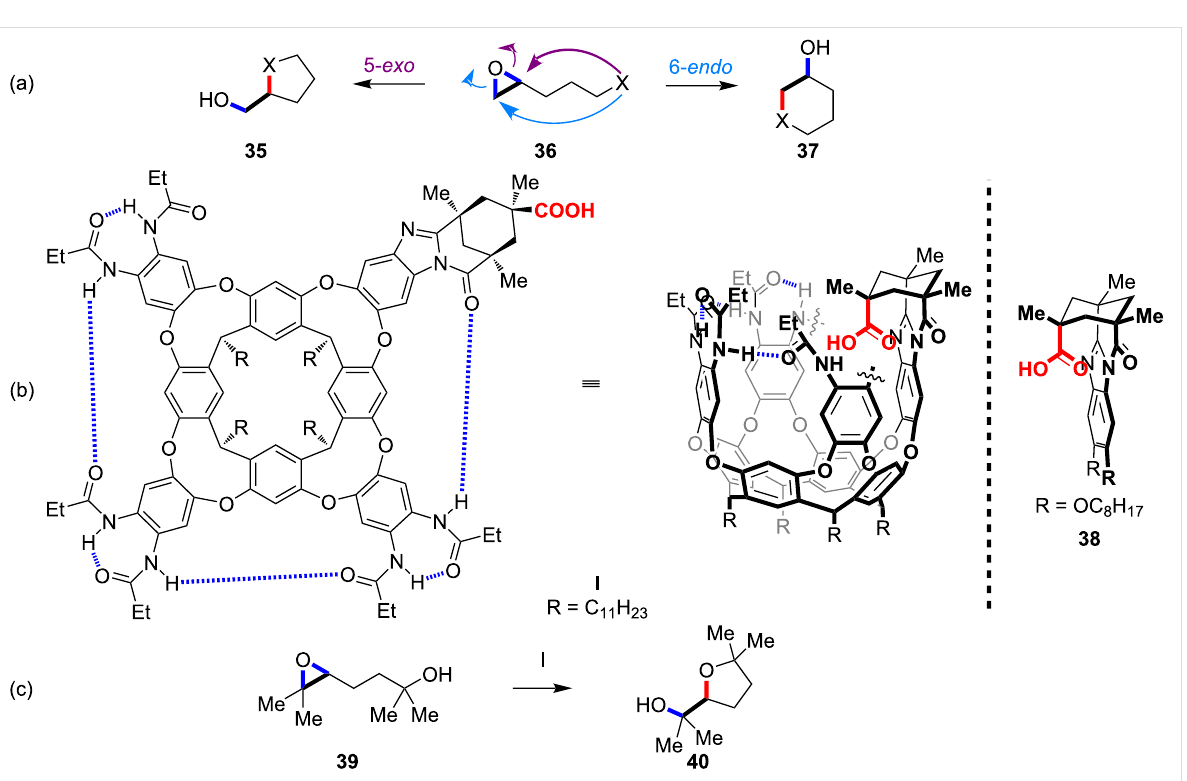
Figure 11: Site-selective ring-opening reaction of epoxides mediated by cavitand I with an inwardly directed carboxylic acid